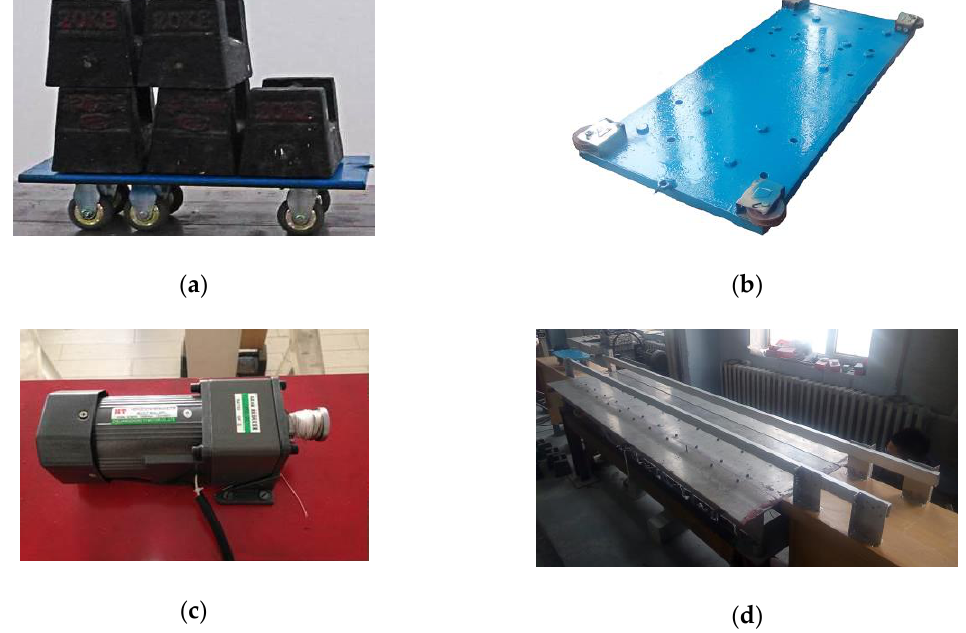
Figure 15. Detailed description and photo of a cross-section of the model bridge (unit: mm).